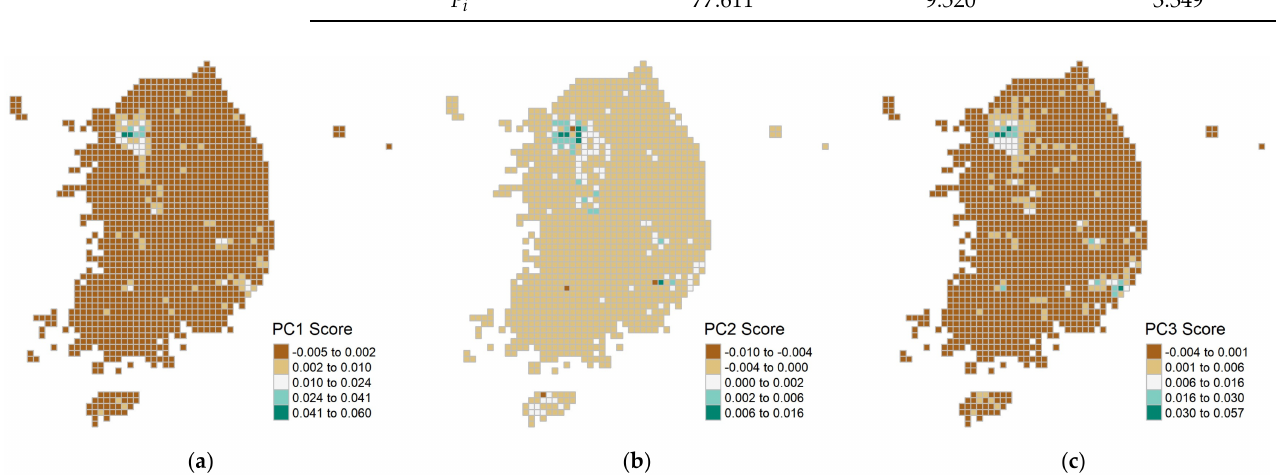
Figure 4. Spatial distribution of the PC scores from the standard PCA: ( a ) PC1 scores; ( b ) PC2 scores; ( c ) PC3